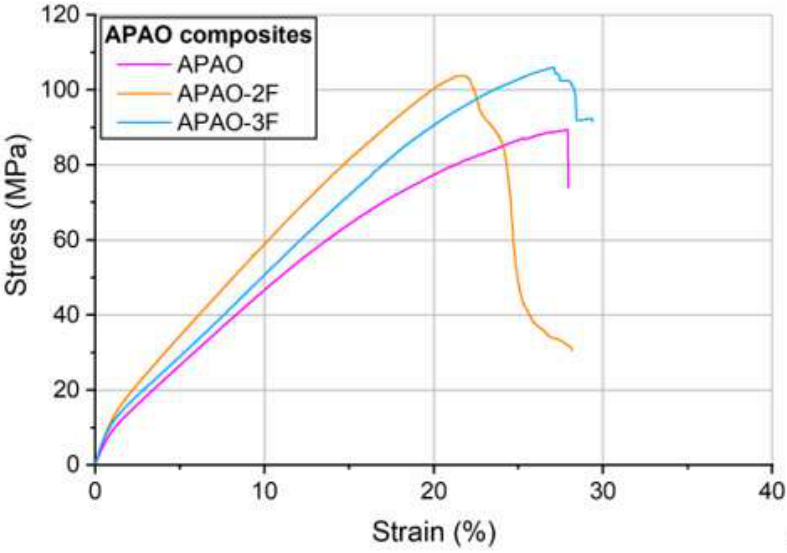
Figure 10. Typical tensile curves of the composites with an APAO matrix with different arrangements.